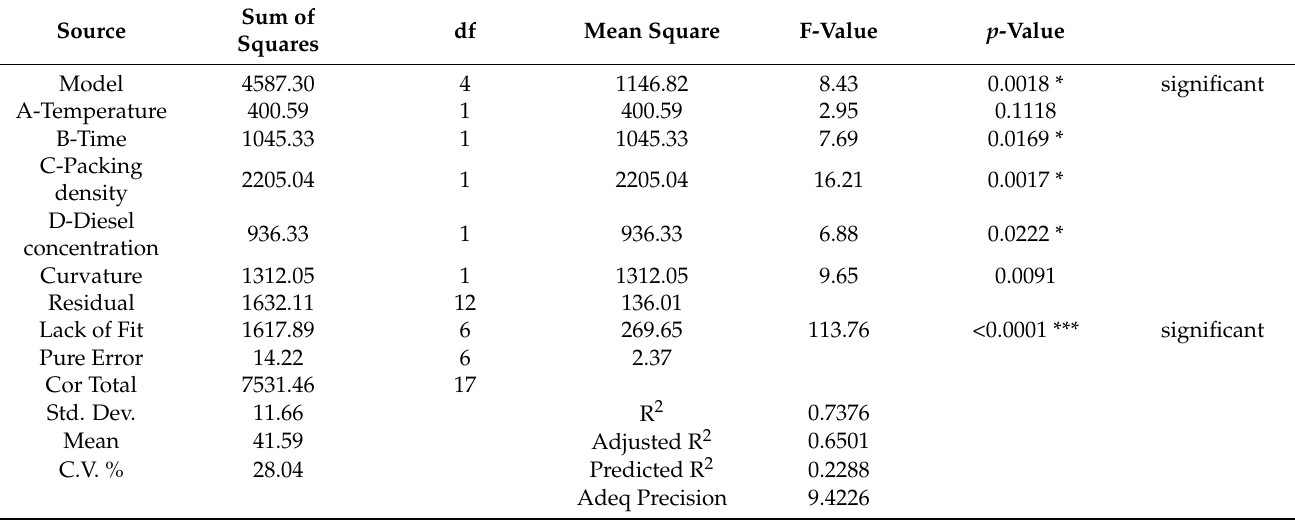
Table 2. ANOVA analysis to determine the significant factors affecting the diesel sorption by